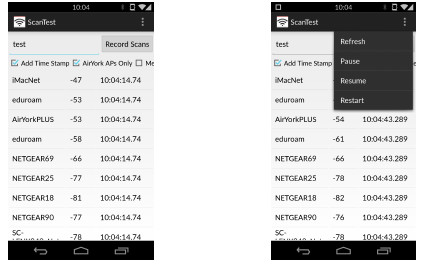
Figure 1. Main User Interface of Android based Data Collection